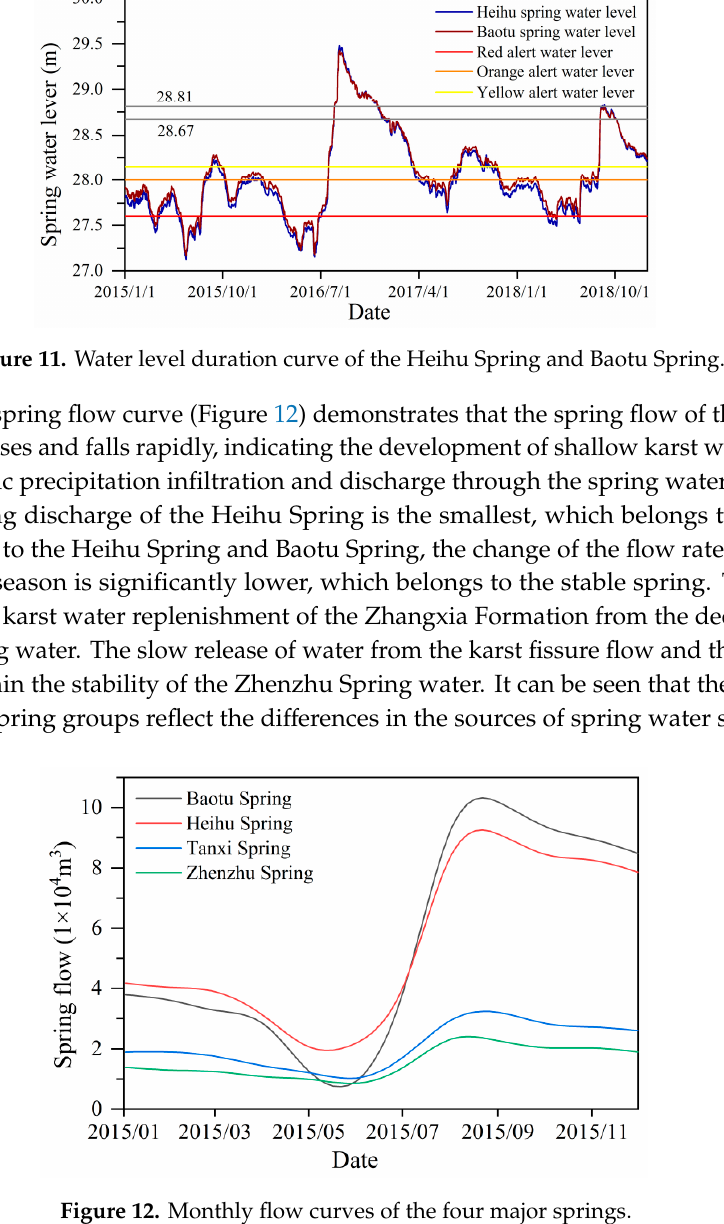
Figure 12. Monthly flow curves of the four major springs.